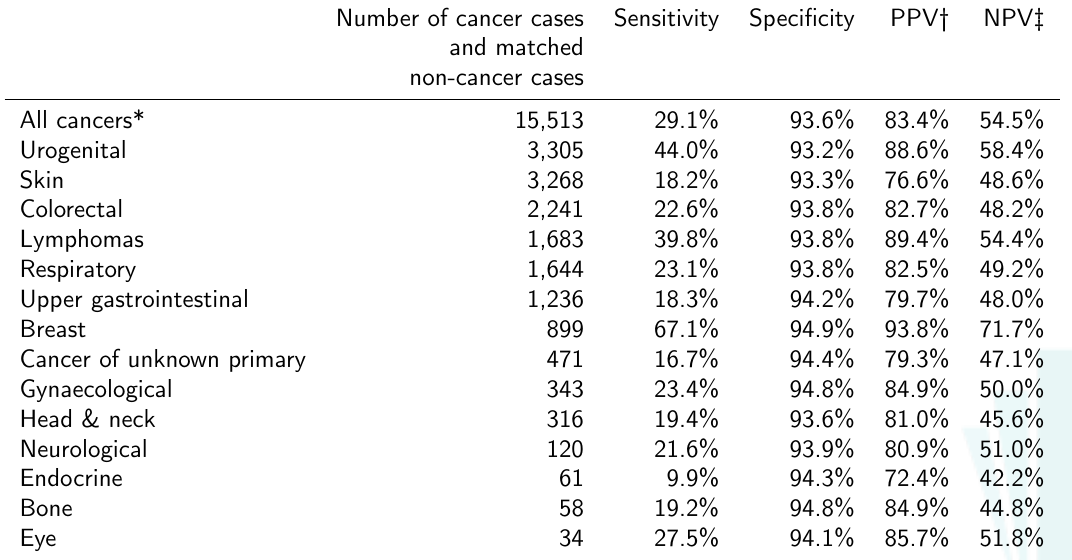
Table 2: Sensitivity, specificity, positive predictive value (PPV), and negative predictive value (NPV) estimates for the